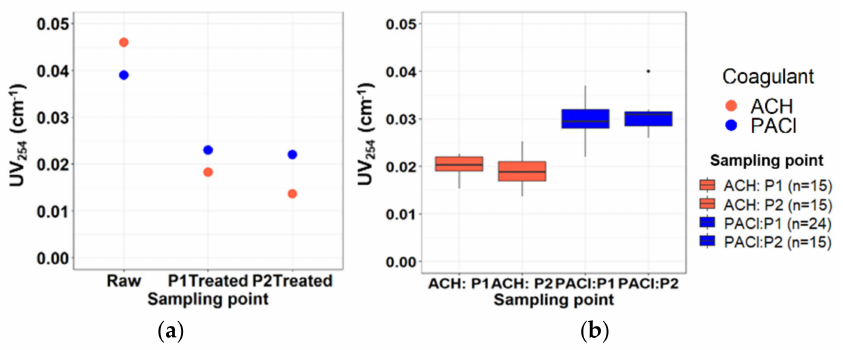
Figure 6. UV 254 absorbance: ( a ) N-WTP, ( b ) N-OKP. Note: P1 denotes Phase 1 and P2 denotes Phase